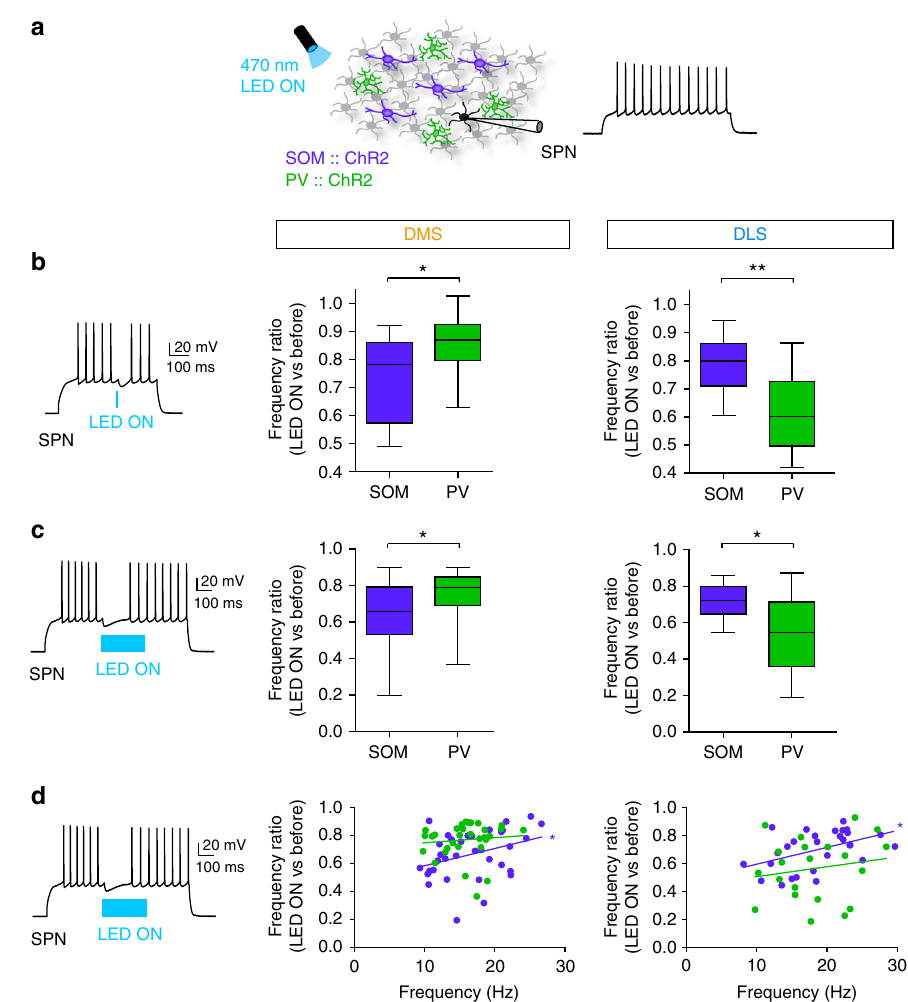
Fig. 4 Differential local inhibitory weight of SOM and PV cells on fi ring SPNs. a In the DMS and DLS, SPNs are recorded while either PV cells or SOM cells are opto-activated with ChR2 with a 470 nm excitation LED. Effect of PV or SOM cells on SPNs was evaluated in active SPNs, i.e., while inducing spiking activity in SPNs by depolarizing current steps (500 ms in b or 1 s in c and d ). b Left: Representative trace of discharge frequency inhibition by a brief (5 ms) opto-activation of PV-DLS cells. Right: Frequency inhibition ratio (frequency during LED ON vs. before LED ON, mean ± SEM) in SPNs induced by 5 ms light pulse. Frequency decrease was signi fi cantly higher for SOM cell (purple) activation in DMS territory ( p = 0.0258, n = 16 SOM cells and n = 16 PV cells), while this decrease was signi fi cantly higher for PV cells (green) activation in DLS territory ( p = 0.0014, n = 14 SOM cells and n = 12 PV cells). c Left: Representative trace of discharge frequency inhibition by long opto-activation of PV-DLS cells. Right: Frequency inhibition ratio (frequency during LED ON vs. before LED ON) induced by 300 ms light pulses. The ratio is signi fi cantly higher for SOM-DMS than PV-DMS cells ( p = 0.0129, n = 14 SOM cells and n = 16 PV cells) and in PV-DLS cells has a stronger weight than SOM-DLS cells ( p = 0.0011, n = 14 SOM cells and n = 12 PV cells). d Correlation of PV (green) and SOM (purple) cell inhibitory weight (discharge frequency ratio) and initial SPN discharge frequency. There is a signi fi cant correlation for SOM cells in both DMS ( r 2 = 0.3481, Pearson's correlation, p = 0.0437, n = 14) and DLS ( r 2 = 0.4648, p = 0.0127, n = 14), and there was no signi fi cant correlation for PV cells ( r 2 = 0.097 for DMS and r 2 = 0.1739 for DLS); * p < 0.05, ** p < fi ring rate ( p = 0.5973 for DMS and p = 0.4509 for DLS), whereas the effect of SOM cells was negatively correlated to the SPN initial fi ring rate ( p = 0.0437 for DMS and p = 0.0127 for DLS) (Fig. 4d). These results show that PV cells have a constant inhibitory weight regardless of the level of SPN spiking activity, whereas feedforward inhibition exerted by SOM cells decreases with increasing SPN spiking activity.